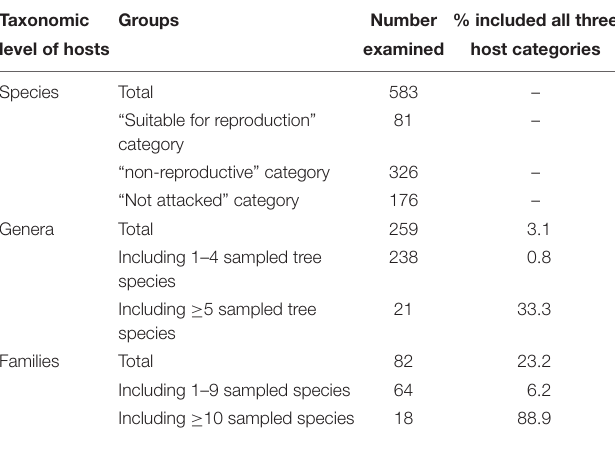
TABLE 1 | Summary of host tree